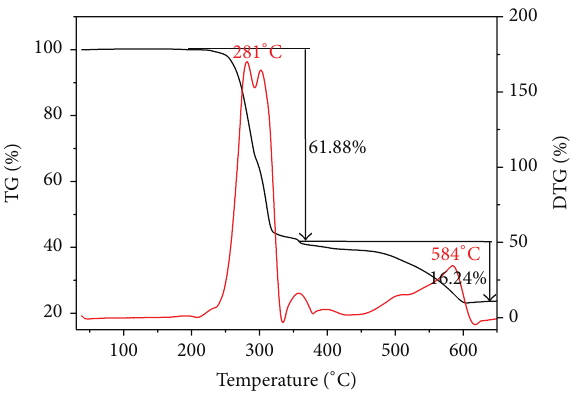
Figure 13: TG-DTG curves of complex 4